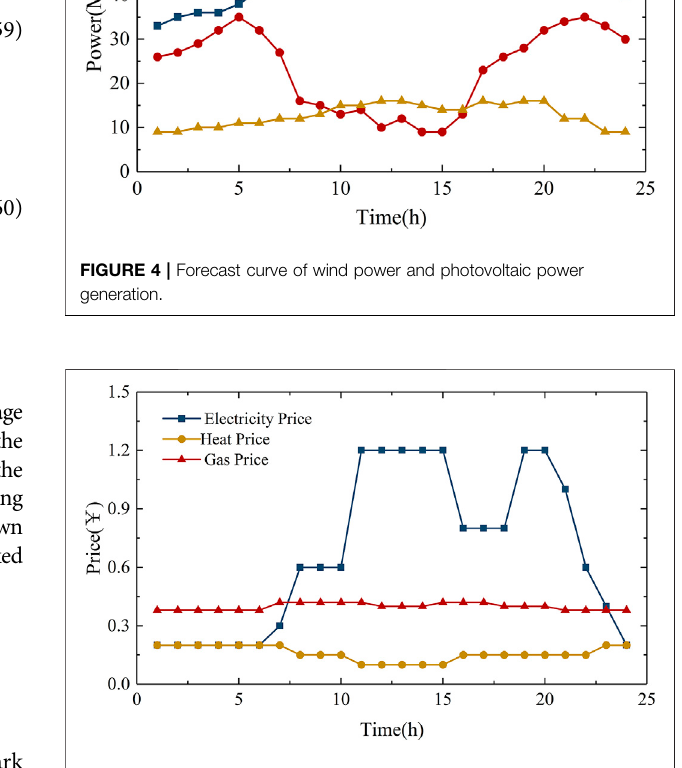
FIGURE 5 | Forecast curve of electricity, heat and gas